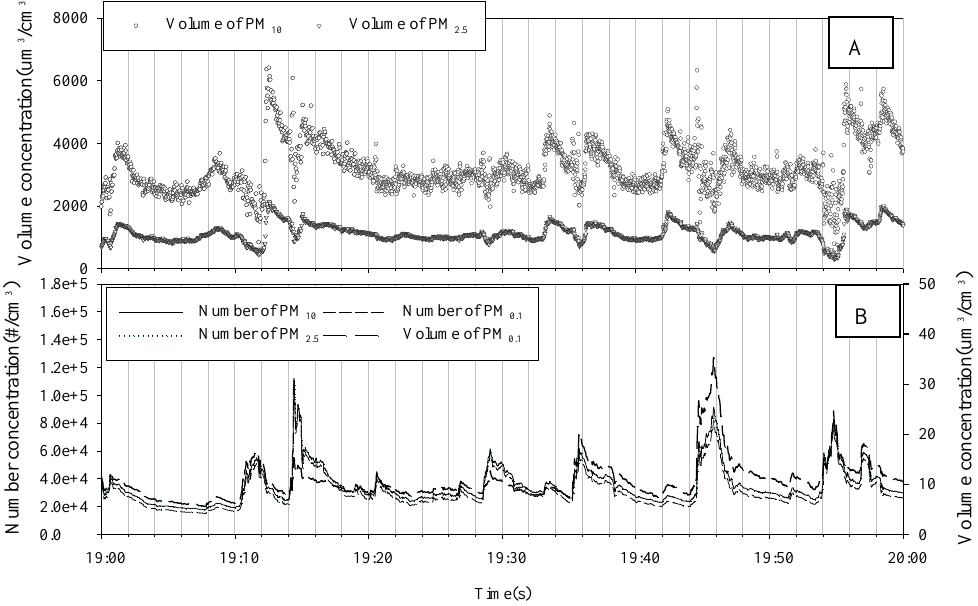
Figure 5. The number and volume of PM in the subway tunnel at the M station between 7:00 and 8:00 p.m. on 15 May 2017.